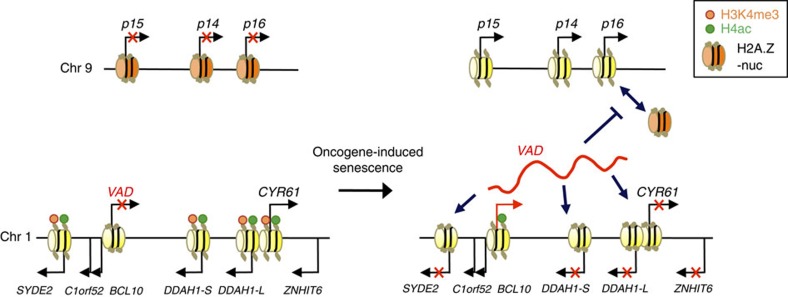
Model of the VAD mechanisms of action in senescence.The expression of the VAD vlincRNA is activated on oncogene-induced senescence. VAD regulates chromatin in cis by promoting the decrease of transcription-linked marks H4ac and H3K4me3 and in trans at the INK4 locus by promoting the removal of repressive H2A.Z, which favours the expression of the INK4 locus genes.